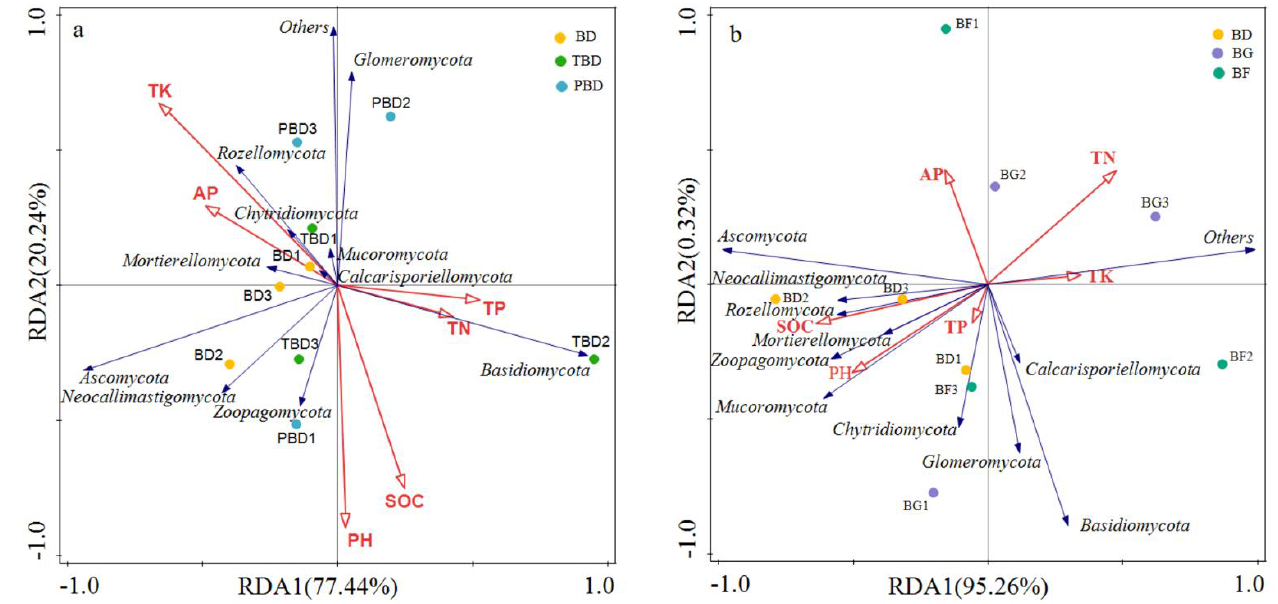
Figure 5. Redundancy analysis of the dominant soil fungal phyla and soil environmental factors. Different cover crops–biochar–organic fertilizer treatments ( a ) and different biochar–organic fertilizer treatments ( b ) groups are listed. Environmental factors are indicated by red arrows, and species are indicated by blue arrows. Different color circles represent each treatment.